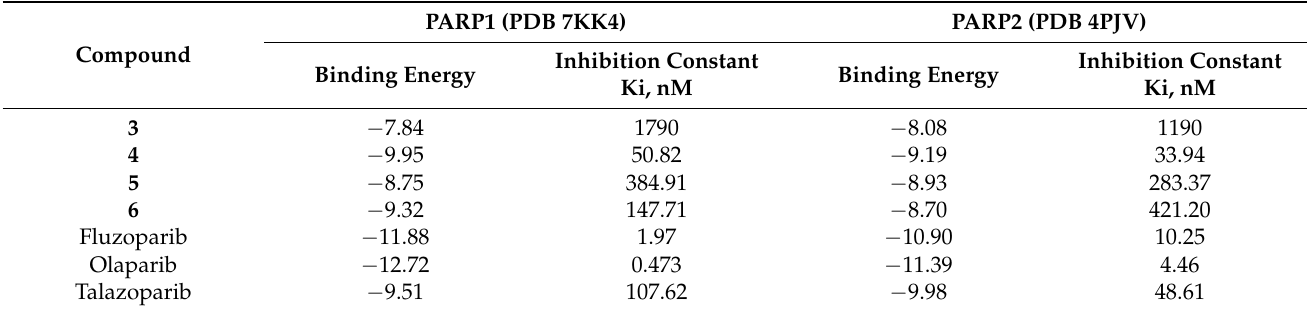
Table 6. Docking scores of the studied compounds.